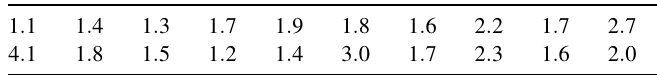
Table 2. Relief times of twenty